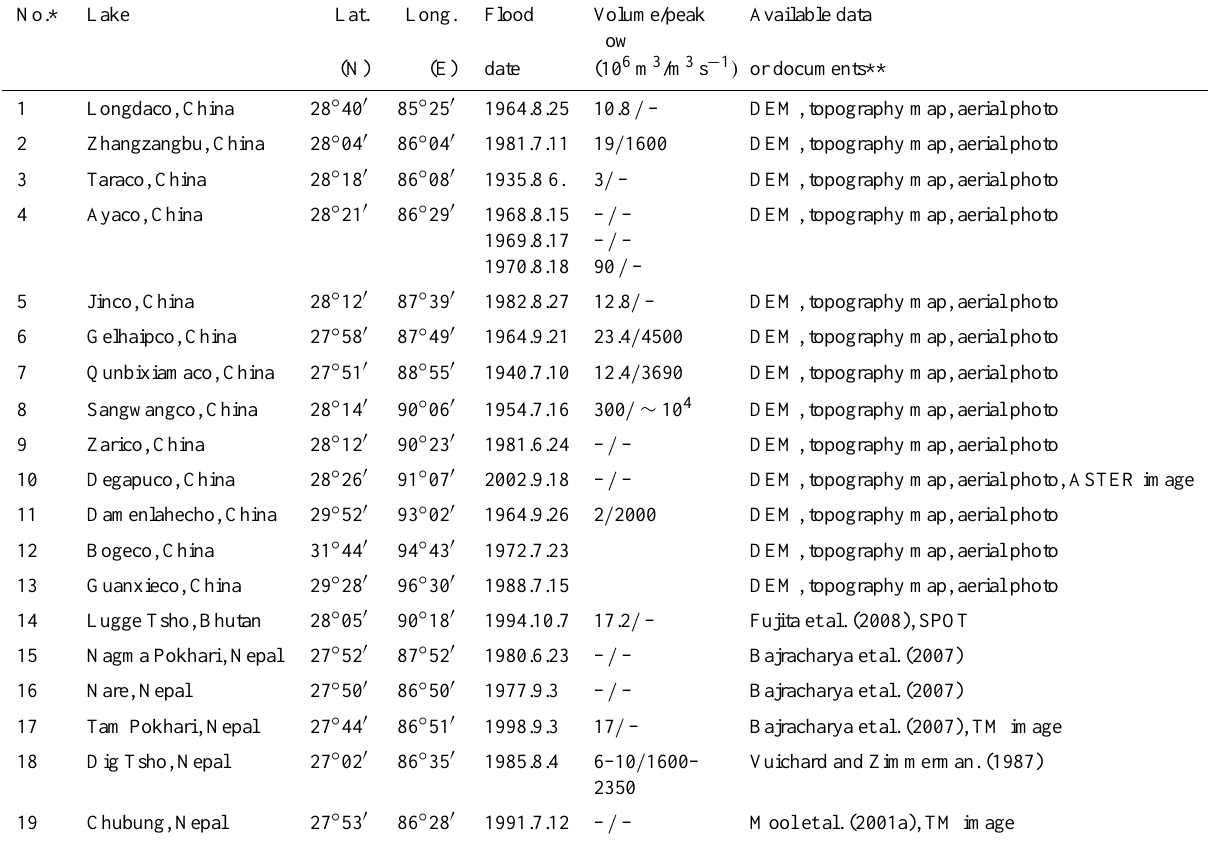
Table 2. Documented MDLOF events for moraine-dammed lakes on the Tibetan Plateau, their size and available data. No.* Lake Lat.